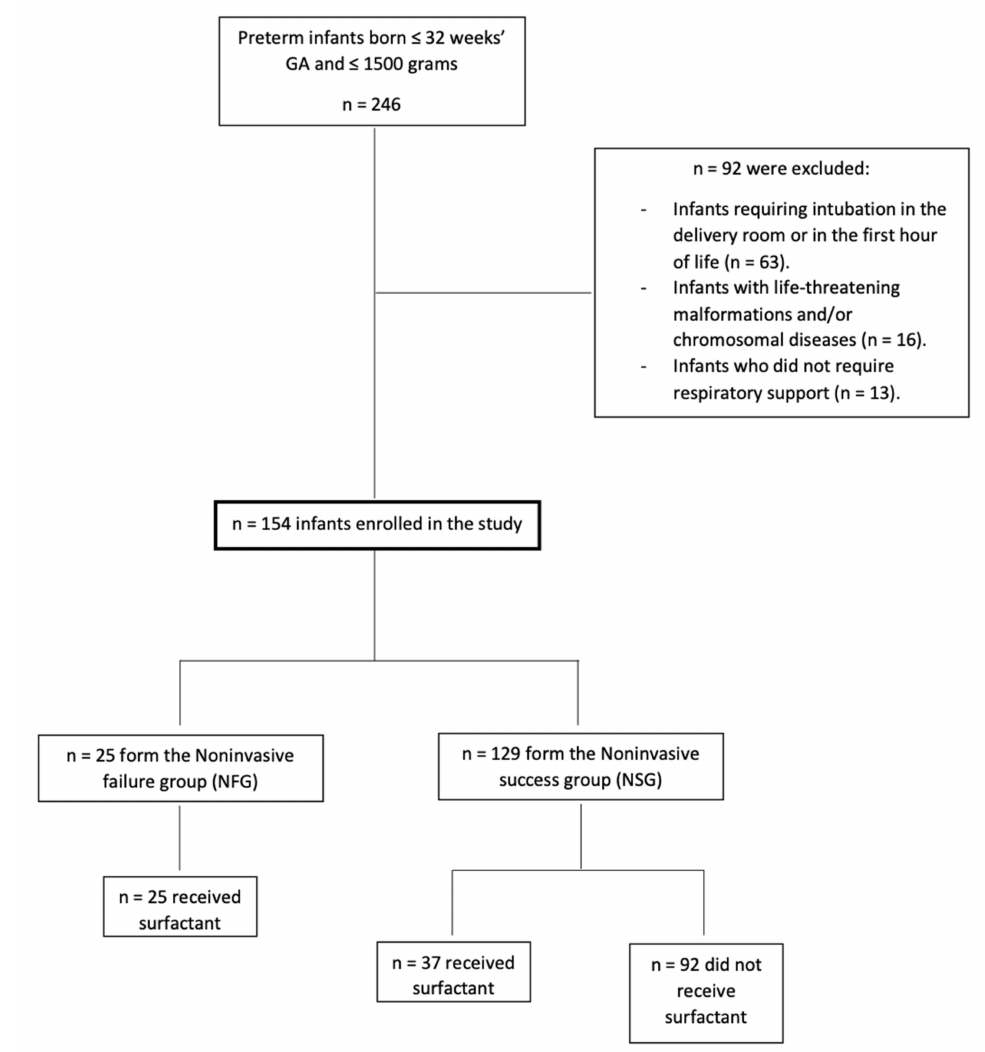
Figure 1. Flow chart depicting recruitment of cohort. Table 1. Demographic and baseline